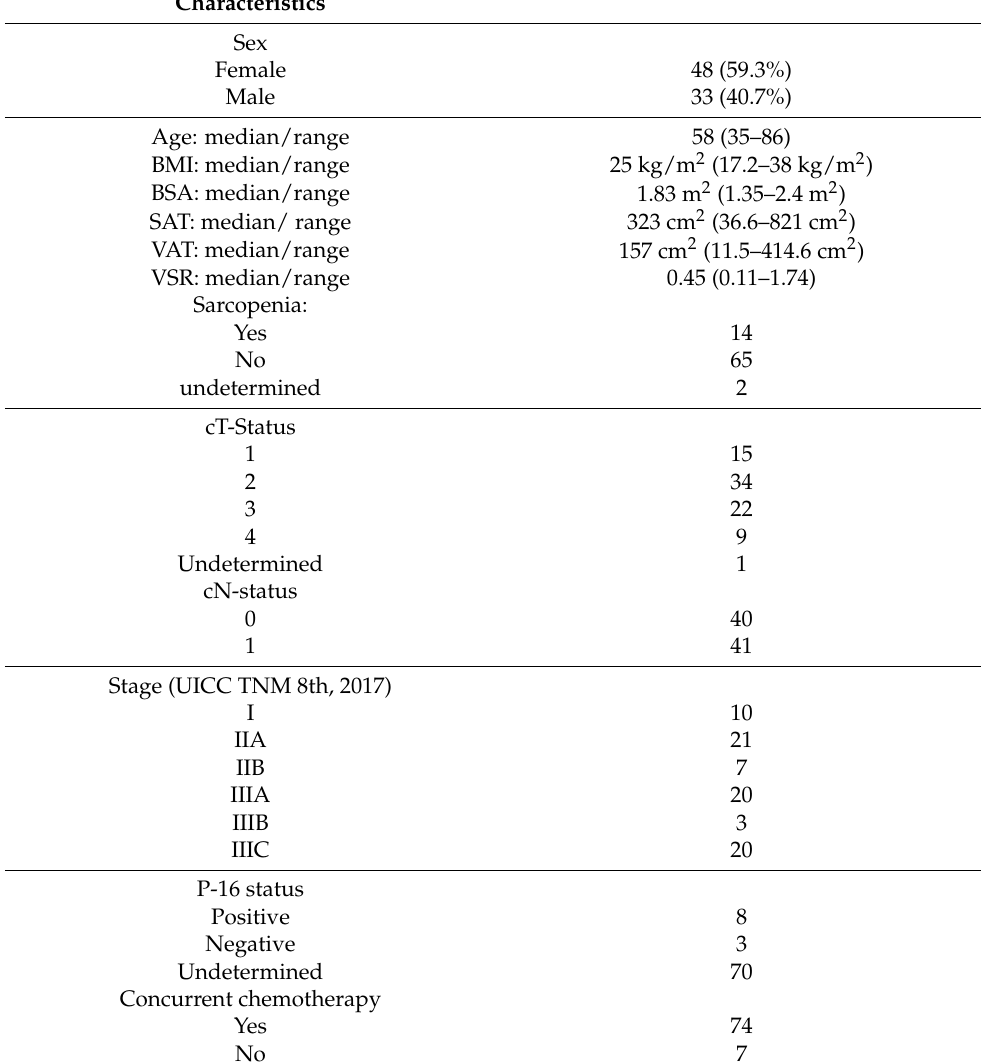
Table 1. Baseline characteristics—BMI: body mass index; BSA: body surface area; VSR: visceral- to-subcutaneous fat ratio; VAT: visceral adipose tissue abdominal; SAT: subcutaneous abdominal adipose tissue; UICC: Union for International Cancer